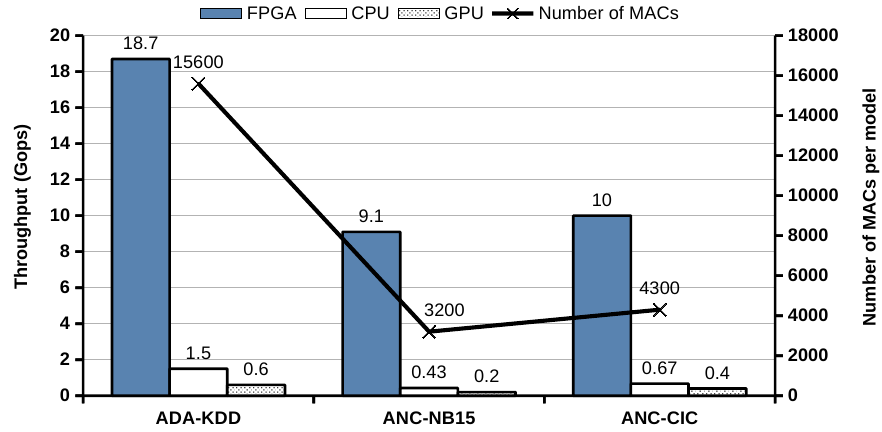
Figure 12. Measurements of throughput and number of MACs of models in the ADNN